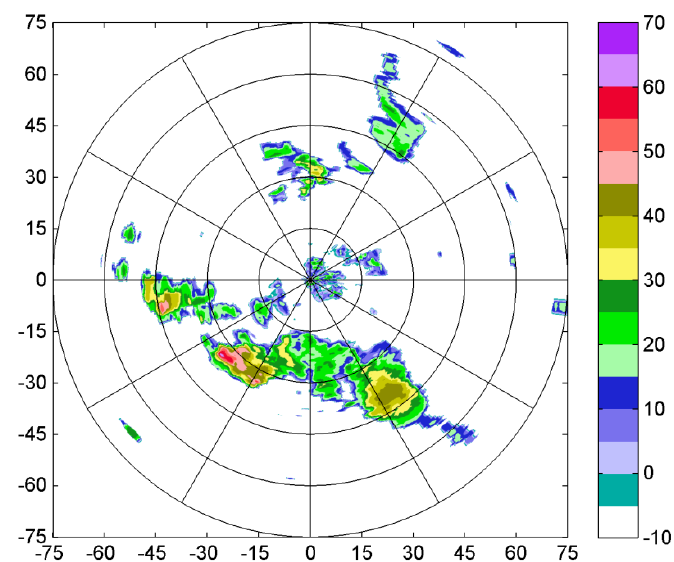
Figure 6. Corrected reflectivity at X-band.